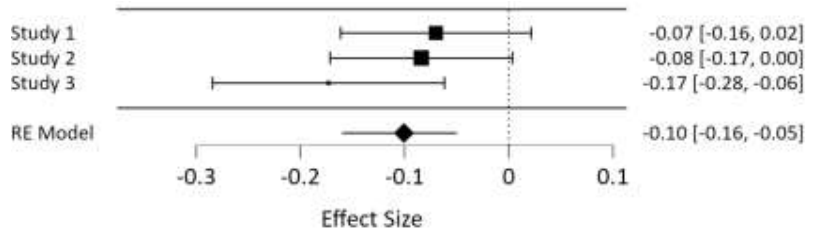
Figure 6. Forest plot of meta-analysis of Introjected regulation and Emotional stability Identified regulation